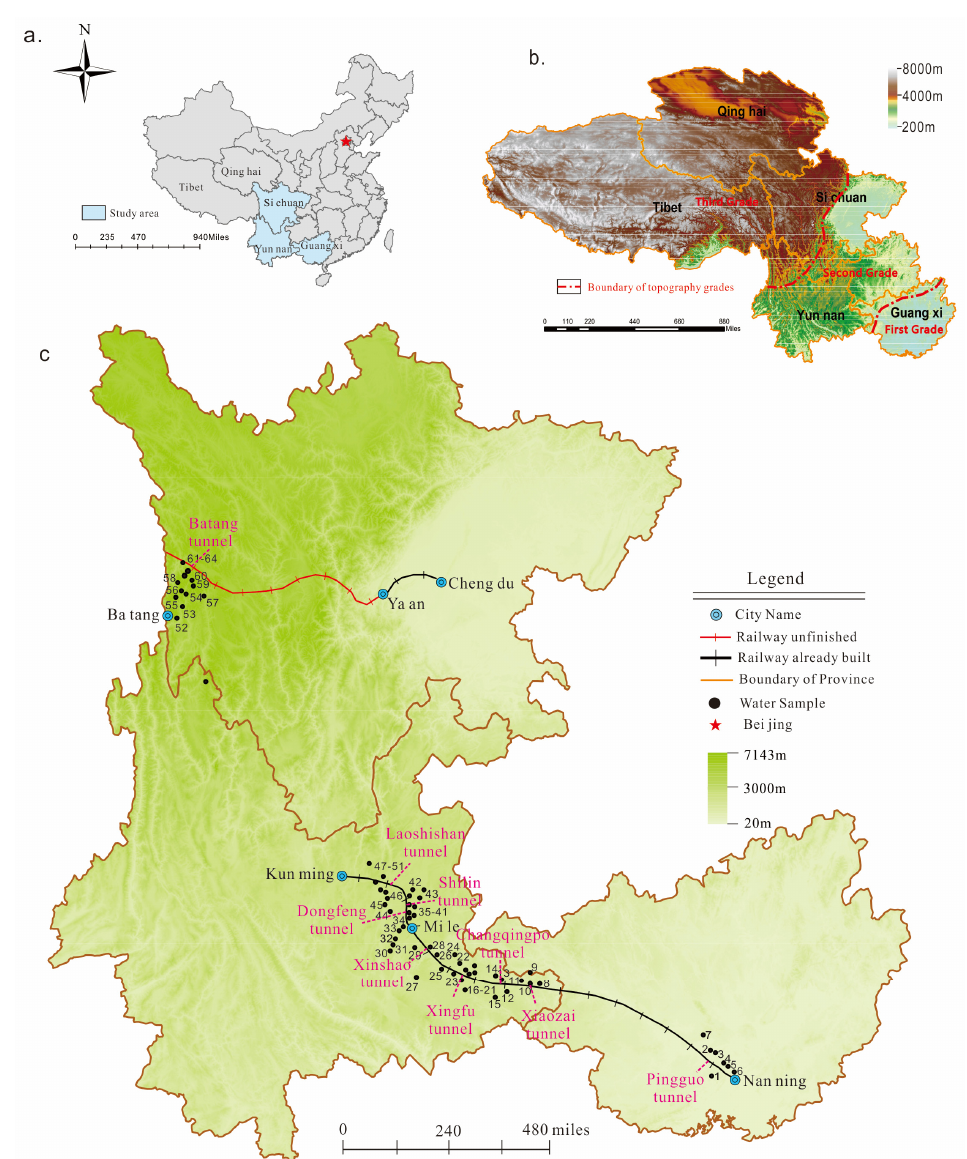
Figure 1. ( a ) Distribution map of provinces in China and Study area. ( b ) Three altitude grades of topography in the study area ranging from 200 m to over 5000 m. ( c ) Water sample location and tunnel distribution.